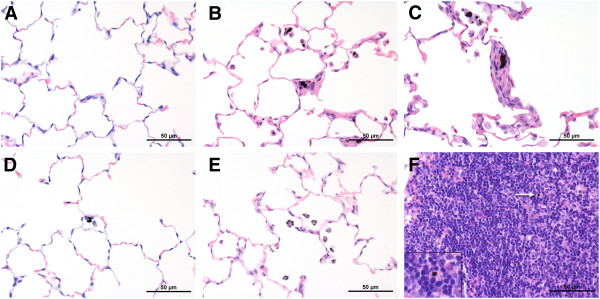
Microscopic appearance of lungs (A-E) and lymph node (F). A – Control. B – MWCNT, 2.5 mg/m3, study day 4: Microgranuloma, particles in the lesion and inside of alveolar macrophages. C – Graphene, 10 mg/m3, study day 7: Microgranuloma, particles within the lesion. D – Graphite nanoplatelets, 10 mg/m3, study day 4: Particles inside of alveolar macrophages. E – Carbon Black, 10 mg/m3, study day 4: Particles inside of alveolar macrophages. F – MWCNT, 2.5 mg/m3, study day 25: Mediastinal lymph nodes with macrophages containing black particles (arrow).